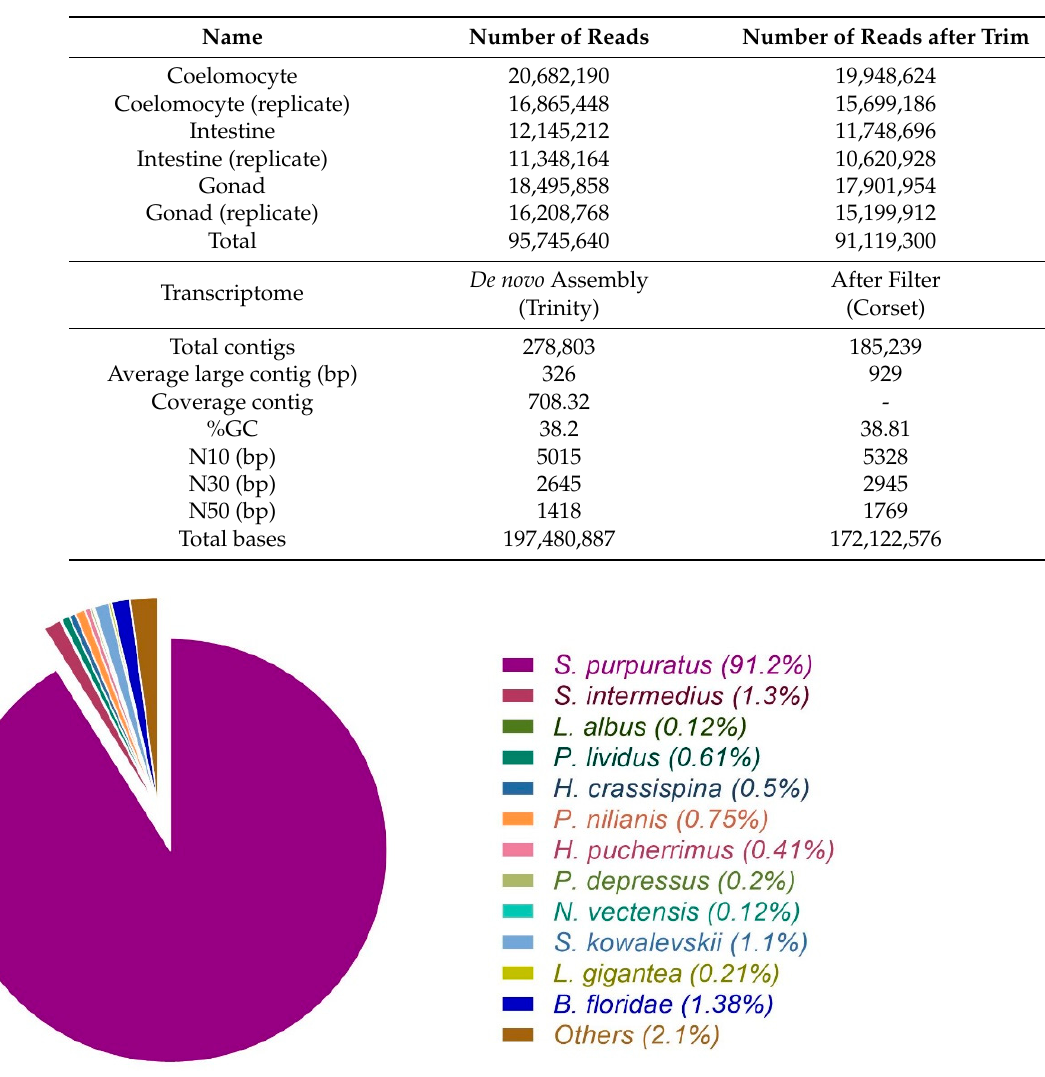
Figure 2. A species-based BlastX comparative analysis revealed the major match with Strongylocentrotus purpuratus . Table 1. Summary of transcriptome sequencing for the edible red sea urchin ( L. albus ) tissue and assembly statistics. bp: base pair.